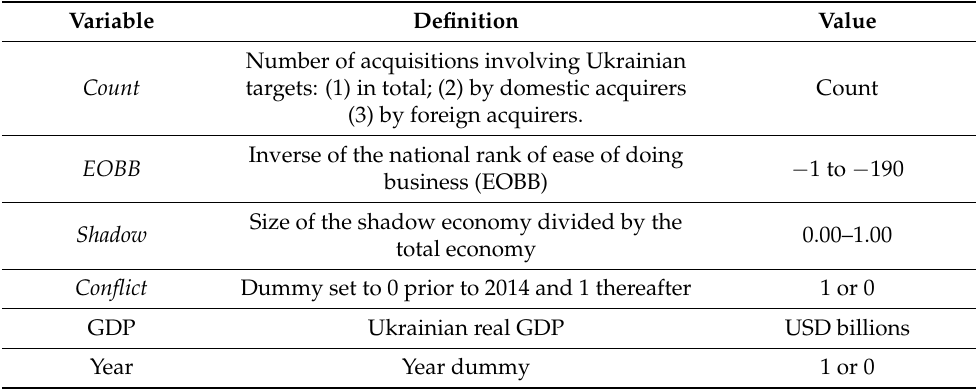
Table 1. Overview of the Key Variables and their